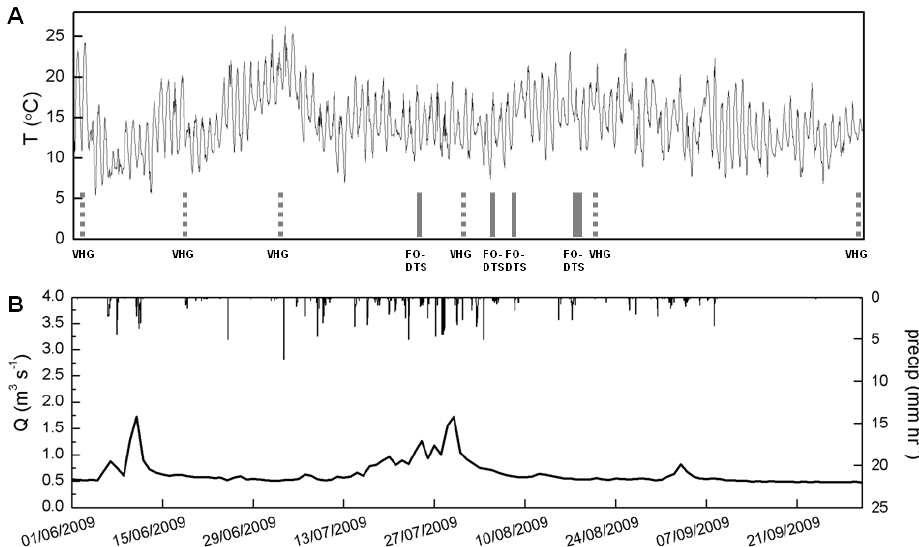
Fig. 4. Hydrometeorological conditions at the fieldsite (A) : air temperatures, (B) : precipitation and river discharge (EA Tern Hill gauging station) for the period of 1 June 2009–30 September 2009. Dotted and solid bars in (A) indicate timing of the VHG and FO-DTS